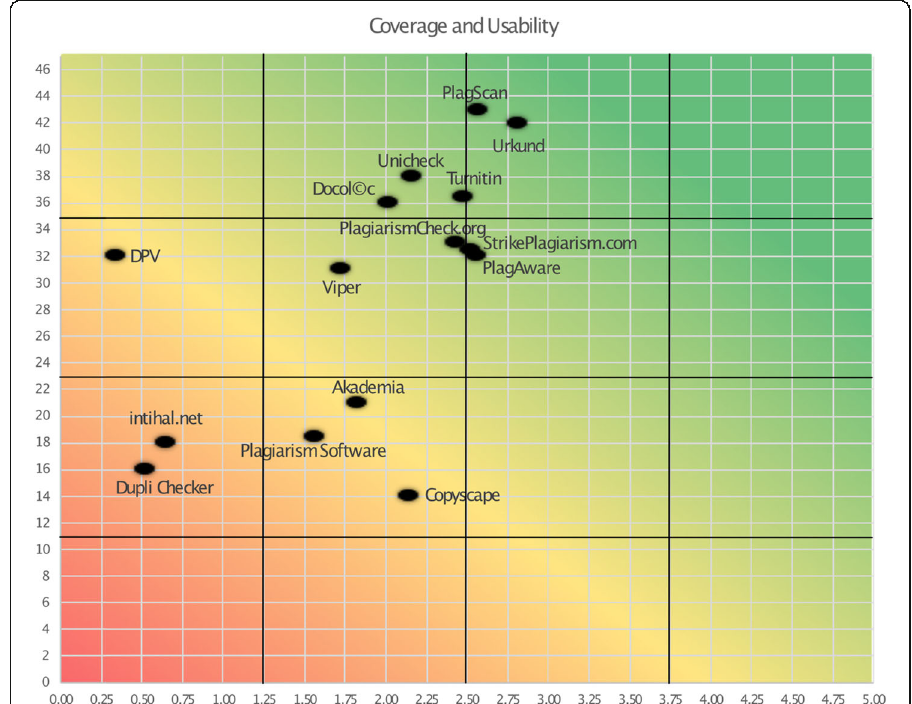
Fig. 1 Coverage and Usability combined. X-axis: Total score for coverage; Y-axis: Total weighted score for